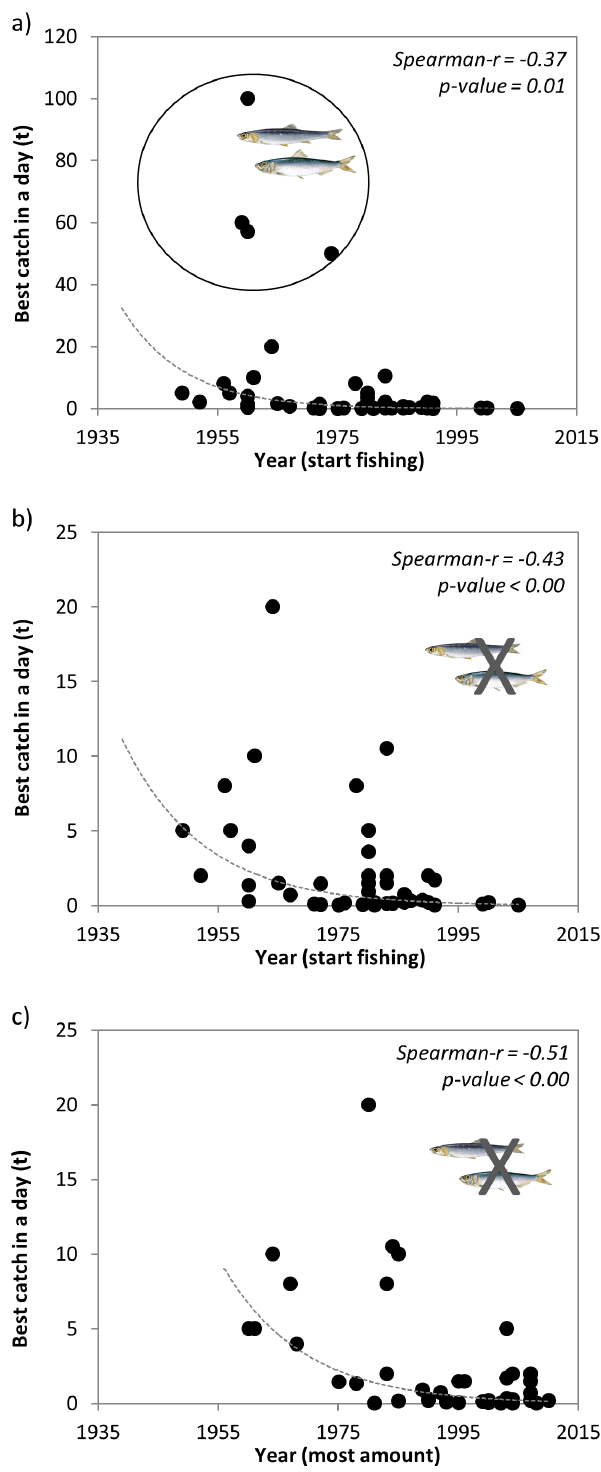
Figure 6. Assessment of the a) best catch in a day of fishing (t) and year of starting fishing (n=47), b) best catch in a day of fishing (t) and year of starting fishing, excluding small pelagic fish and squids (n=43), and c) best catch in a day of fishing (t) (n=43) and year of the best catch. (Species drawings: www.gencat. cat).